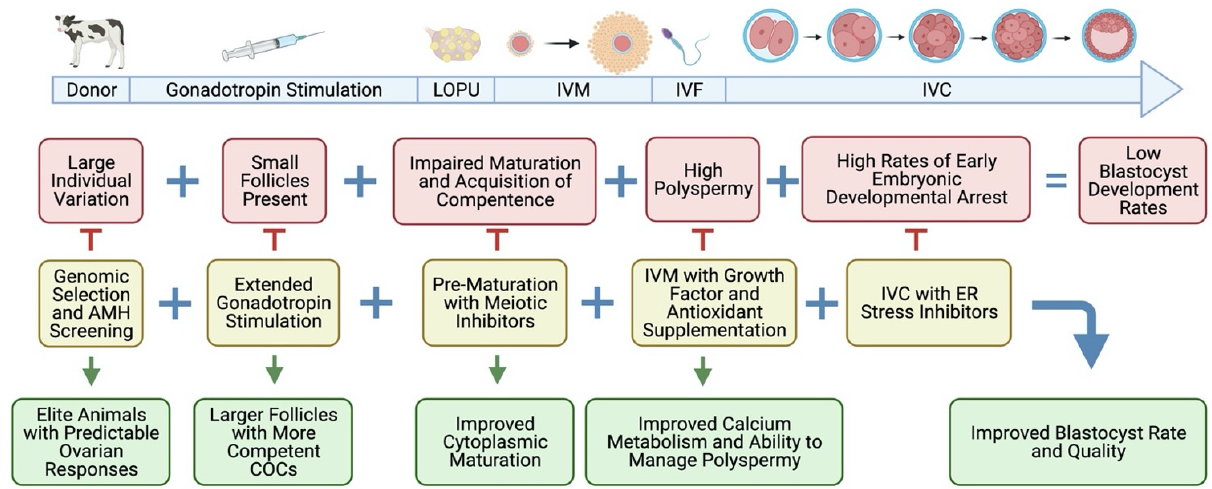
Figure 2. Overview of LOPU-IVEP in prepubertal cattle and buffalo, showing potential targeted approaches to address the main problems holding the technology back. Figure created with BioRender.com, accessed on 30 July 2021.